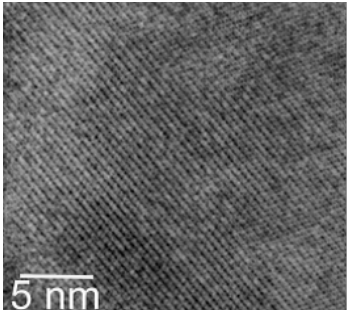
Figure 13. High-resolution Transmission Electron Microscopy (HRTEM) image for the best mi- crostructure corresponding to domain size of